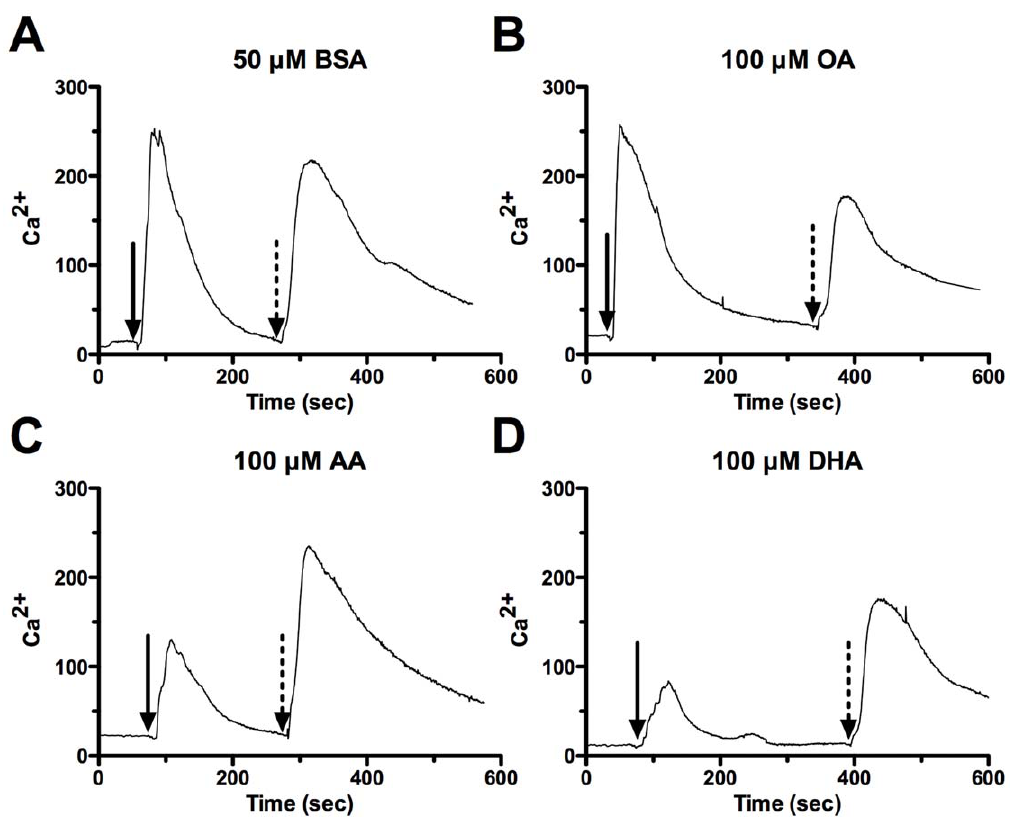
Figure 2. Representative [Ca 2 + ] i traces recorded from PHM1-41 cells. Cells were treated with (A) 50 m M BSA, (B) 100 m M OA, (C) 100 m M AA, (D) 100 m M DHA. Arrows indicate application of 25 nM oxytocin (solid) and 100 nM thapsigargin (dashed). Values are mean of 23–26 cells.